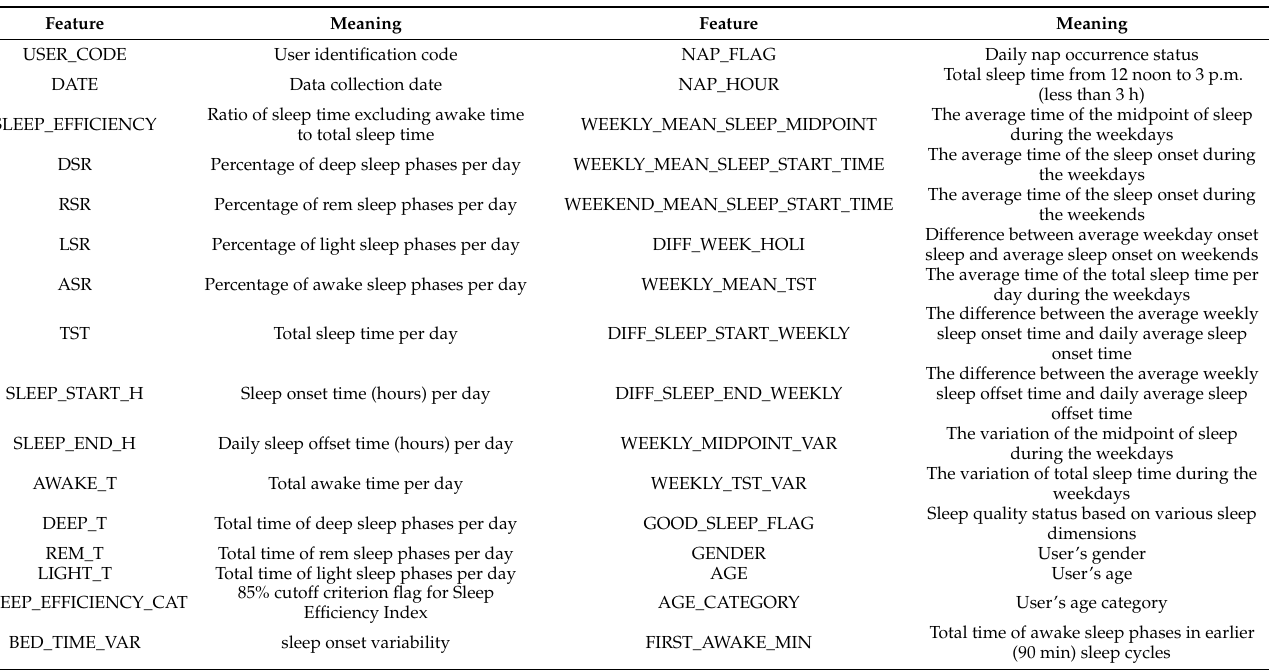
Table 2. Feature names and descriptions as generated from raw data collected daily/per